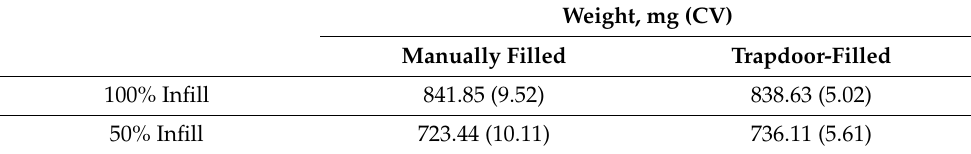
Table 4. Weight data relevant to uncoated I-shaped samples printed by setting different infill.